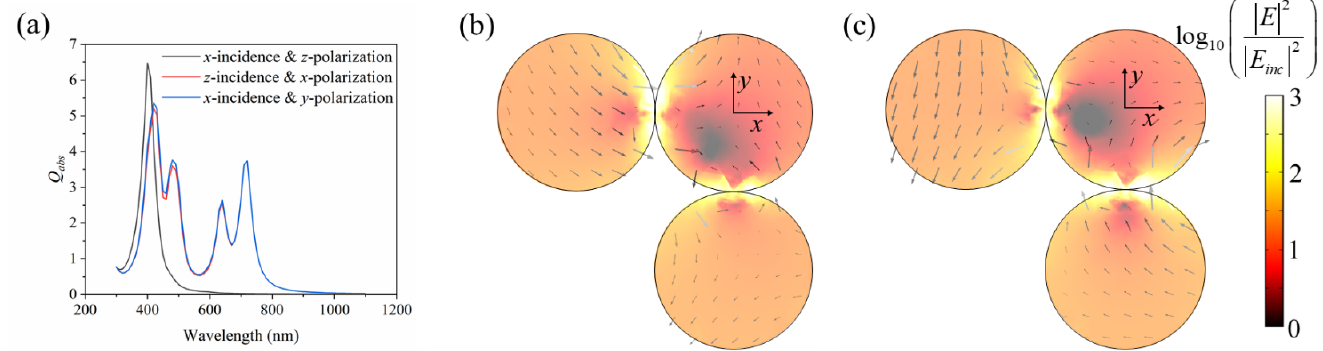
Figure 12. ( a ) Absorption efficiency in three directions of a right-angled trimer and the electric field of ( b ) z -incidence with x -polarization and ( c ) x -incidence with y -polarization at λ = 420 nm.